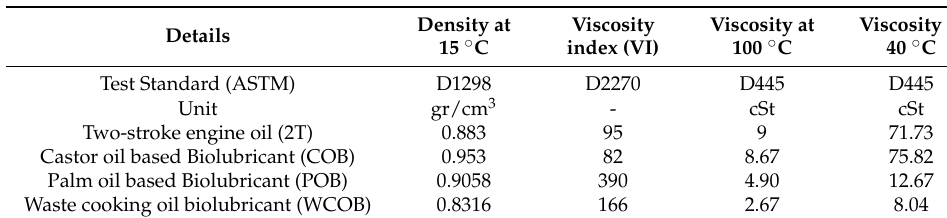
Table 1. Physical properties of the lubricants applied in the engine test.